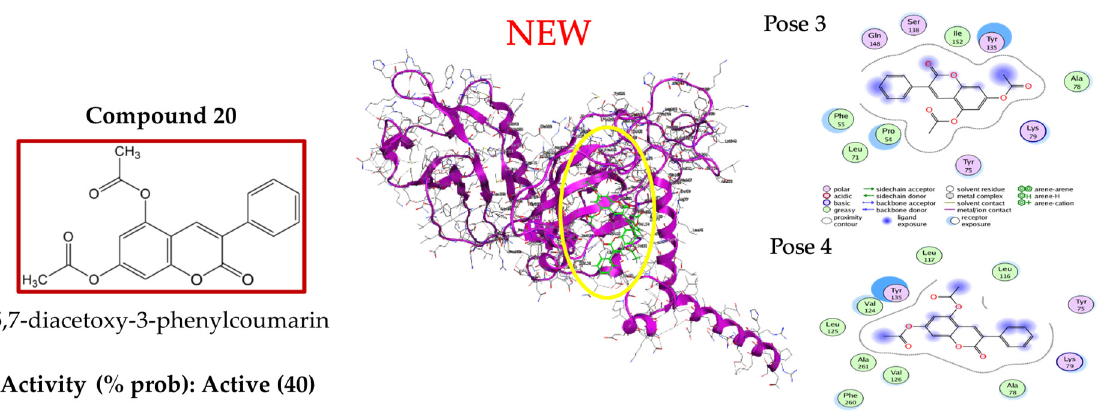
Figure 14. Interaction network between monomeric protein AHR, ARNT and the studied compound Figure 14. 20 . compound 20